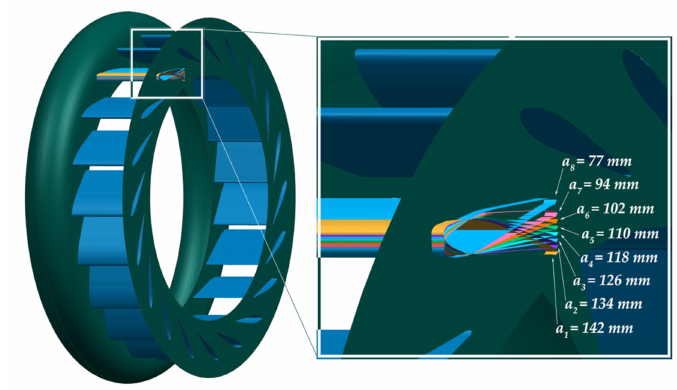
Figure 4. Schematic drawing of different guide vane openings.